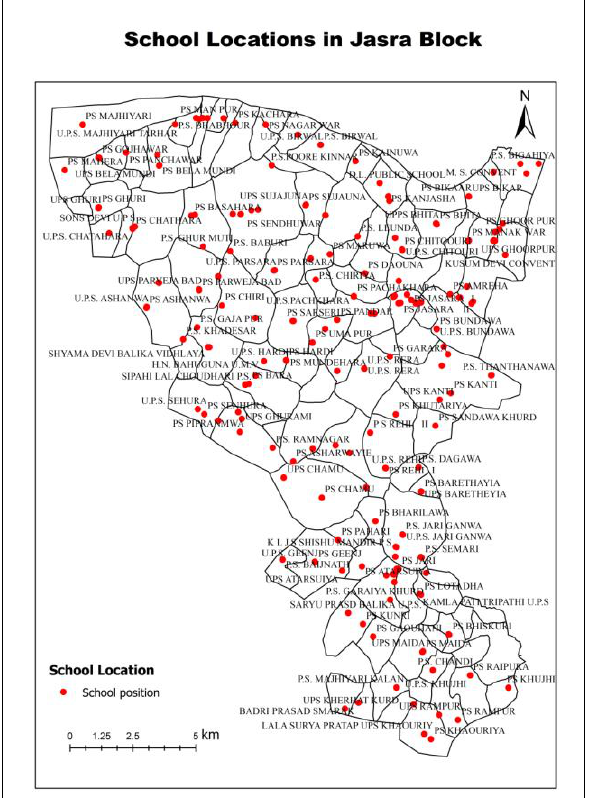
Figure 1. Literacy map of Jasra block